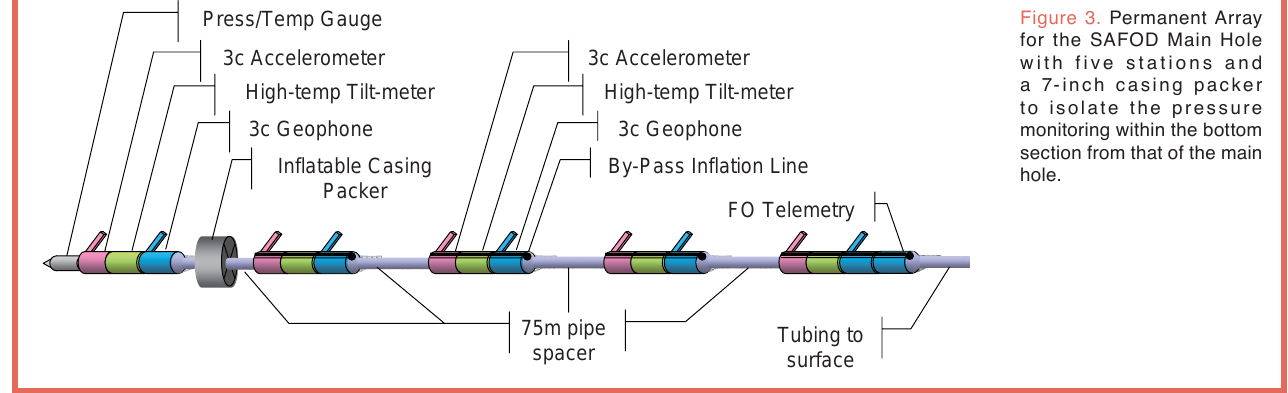
Figure 3. Permanent Array for the SAFOD Main Hole with five stations and a 7-inch casing packer to isolate the pressure monitoring within the bottom section from that of the main